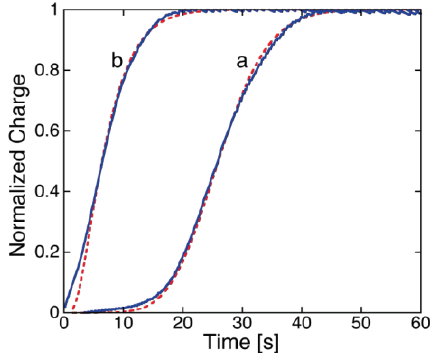
Figure 8. The solid curves are charge vs. time curves at a DPTL/DPhPC tBLM following potential steps from −0.20 to −1.05 V in aqueous 0.1 M KCl containing 0.14 μM melittin. Curve (a) was obtained after keeping the potential at −0.20 V for 15 min; curve (b) was obtained after keeping the potential at −1.05 V for 150 s, stepping it back to −0.20 V and carrying out the recorded potential jump to −1.05 V immediately after. The dashed curve (a) was calculated using the parameters θ 0 = 0.2, n = 2, k h , N v h , R 2 = 0.08 s −3 , k N k R 2 = 0.05 s −3 and p = 1; the dashed curve (b) was calculated using the parameters θ 0 = 0.2, n = 2, k N k R 2 = 40 s −3 and p = 1. (Reprinted with permission from [30]. Copyright 2007, American Chemical